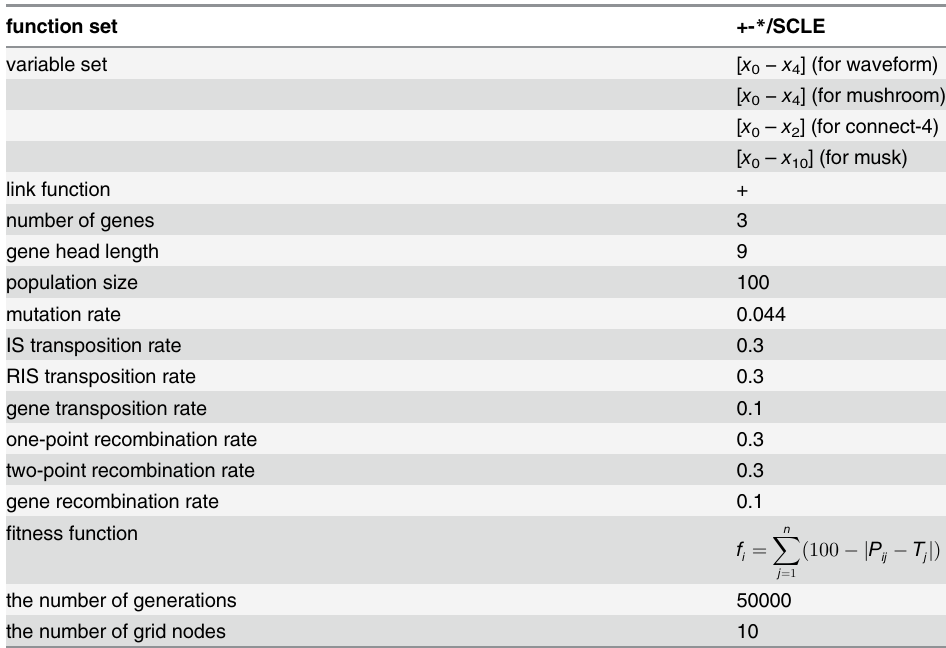
Table 5. Parameters of DFMGEP-FR.